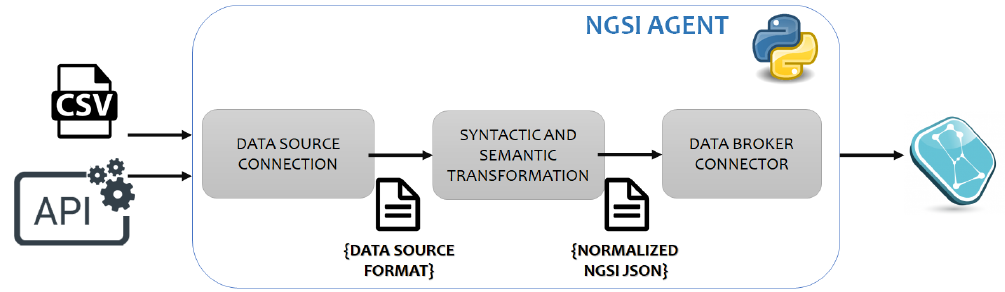
Figure 12. NGSI agent internal process for data conversion in the TCI experiment.